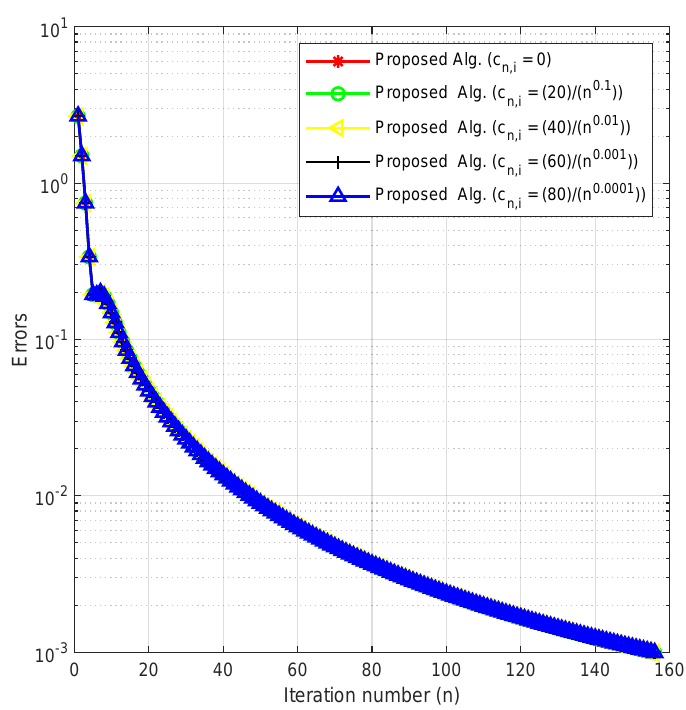
Figure 2. Experiment 1: m =